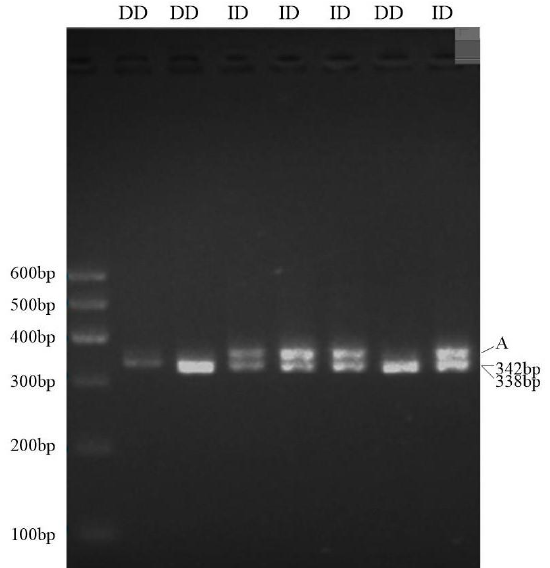
Figure 2. The LRRC8B gene InDel site using gel electrophoresis. Note: the letter “A” indicates a heterogenous double chain.